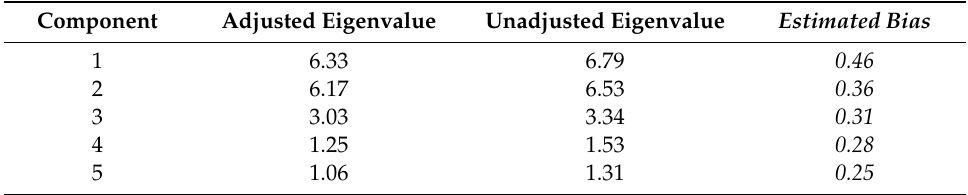
Table 7. Parallel analysis performance for component retention decisions across 25 BWS statements.